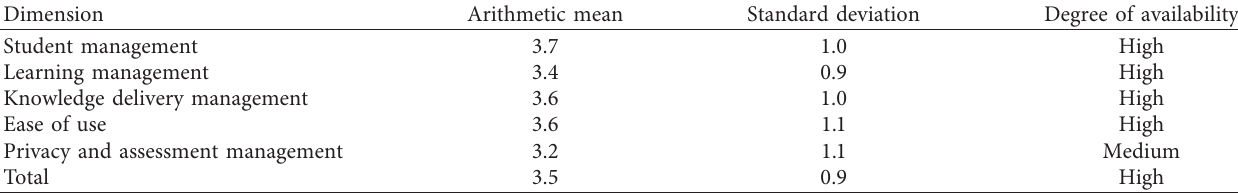
Table 8: Results of the quality scale of programs used in e-learning from the students’